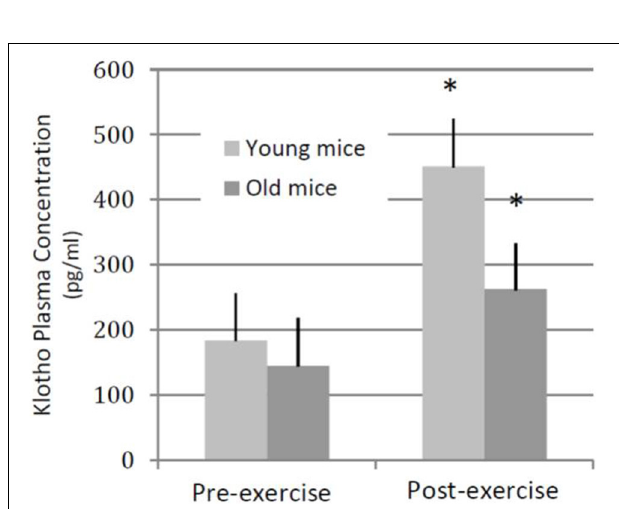
greatest expression, whereas skeletal muscle, ovaries and testes express Klotho to a relatively lesser extent. (Reproduced from Kuro-o et al., 1997).